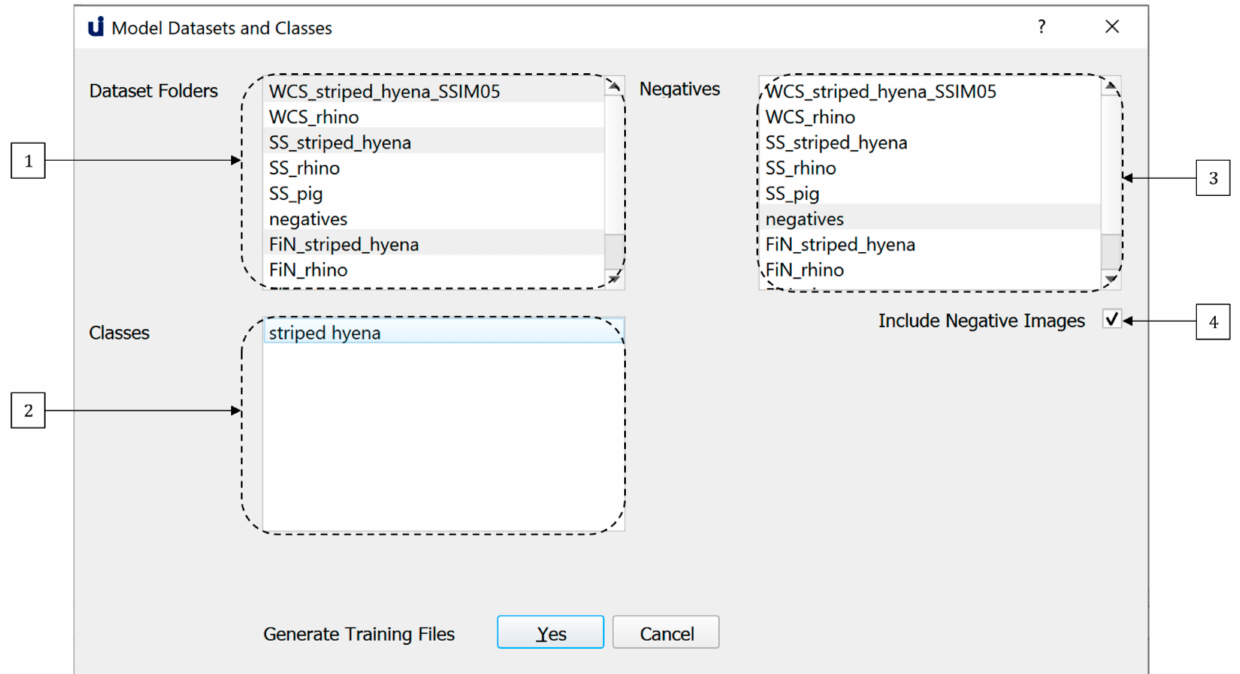
Figure 5. The Model Training dialogue allows users to custom train models on datasets and classes of their